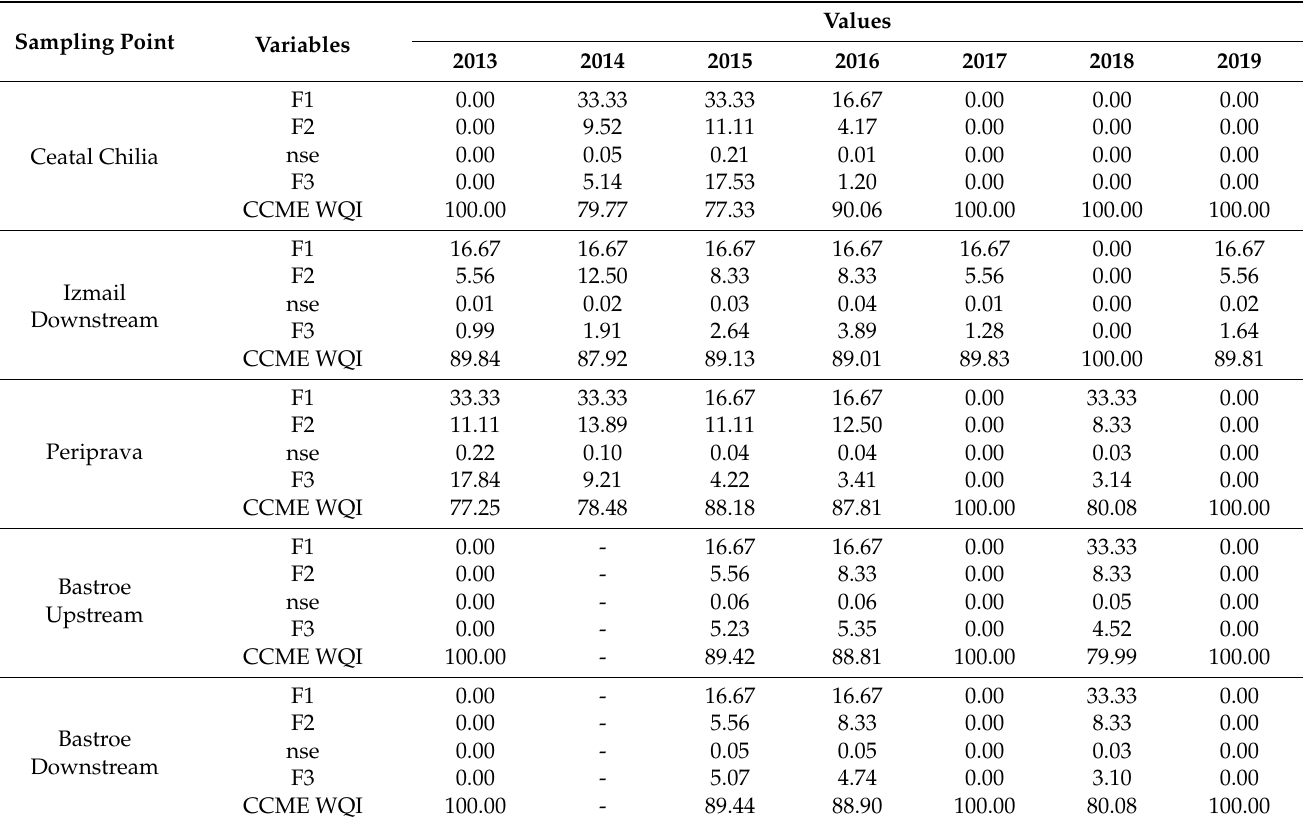
Table 6. CCME WQI evaluation values of the Chilia branch